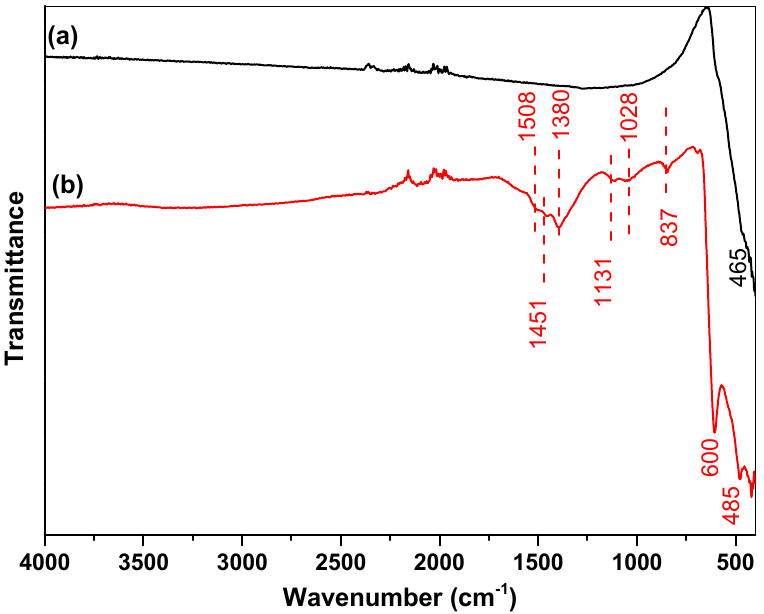
Figure 2. FT-IR spectra of ( a ) bulk fabricated CuO and ( b ) PSE-capped Cu 2 O / CuO materials fabricated by the aqueous solution combustion approach.